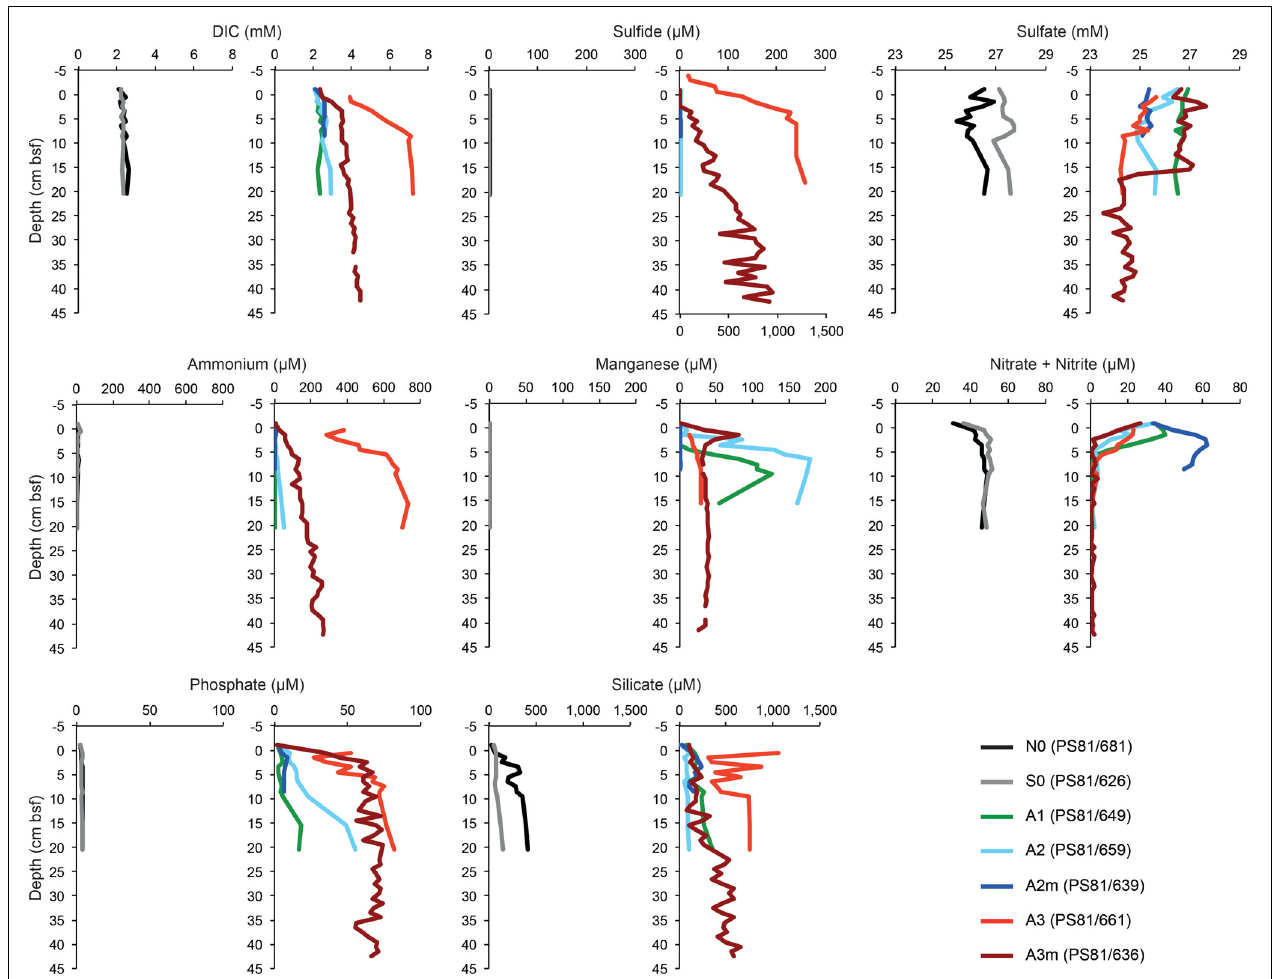
FIGURE 2 | The porewater profiles of surface sediments (0–5 cm) outside and inside the SWIR. The gray (southern reference) and black lines (northern reference) represent outside SWIR stations, the colored lines inside samples. The sulfide plot values for station A3 (PS81/661) refer to the bottom x -axis, for all other stations the values refer to the top x -axis. DIC, dissolved inorganic carbon; cm bsf, centimeters below